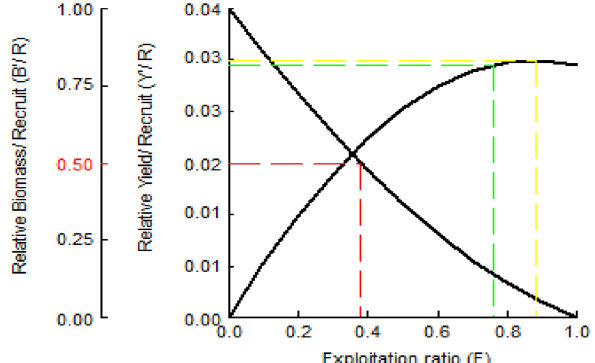
Figure 9. Yield per recruit analysis of M. mastacembelus population inhabiting Keban Dam